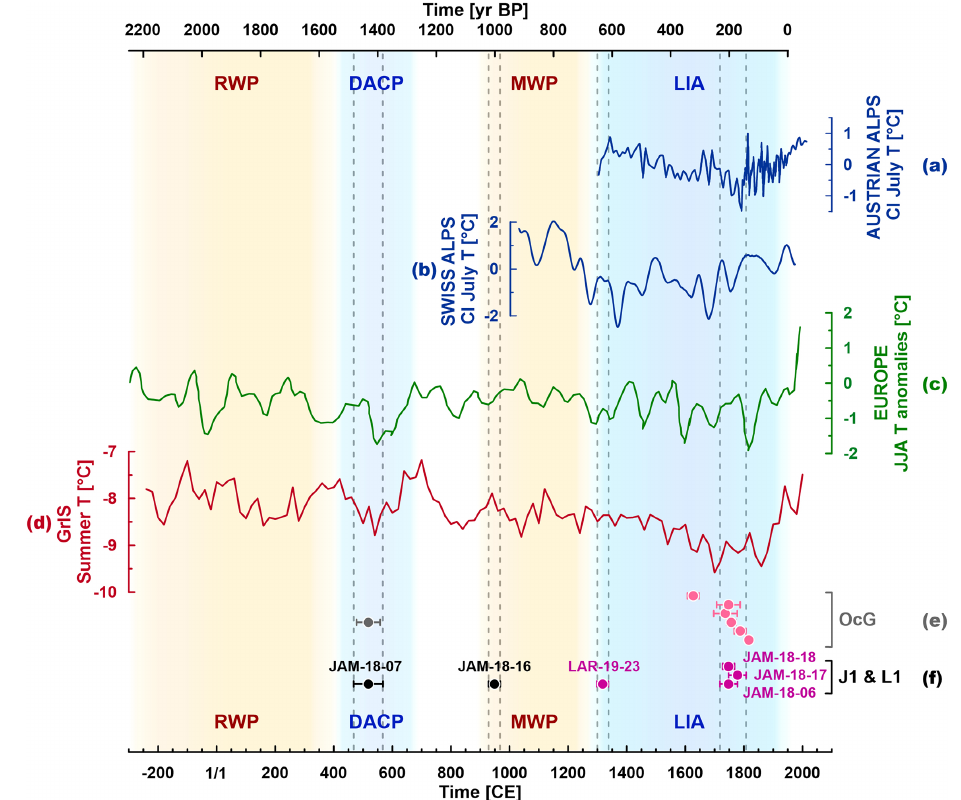
Figure 8. The youngest part of the 10 Be chronology from Jamtal and Laraintal correlated with climate proxy data from the Alps (local records in dark blue), Europe (green), and the Greenland Ice Sheet (GrIS in red) covering the past ca. 2000 years. Proxy records indicate cooler climate conditions during the Dark Ages Cold Period (DACP) and during the Little Ice Age (LIA), synchronous with periods of moraine formation in the Silvretta region. Chironomid-inferred (CI) July temperatures from (a) Mutterbergersee in the Stubai Alps, Austria (Ilyashuk et al., 2019), approximately 70km east of study site (north of the Alpine drainage divide) and (b) lake Silvaplana, around 60km southwest of study site (Engadin, Switzerland; south of the Alpine drainage divide) (Larocque-Tobler et al., 2010a). (c) European summer temperature anomalies (reference period 1961–1990, 60-year low-pass filter) identified in tree-ring chronologies (Büntgen et al., 2011). (d) Mean summer temperature reconstructions (JJA) derived from nine Greenland ice cores (Buizert et al., 2018). (e) 10 Be ages of boulders sampled from the presumable LIA (Holocene composite moraine) from Ochsental (OcG) (Braumann et al., 2020) and from (f) Jamtal and Laraintal (this study). RWP stands for Roman Warm Period, and MWP stands for Medieval Warm